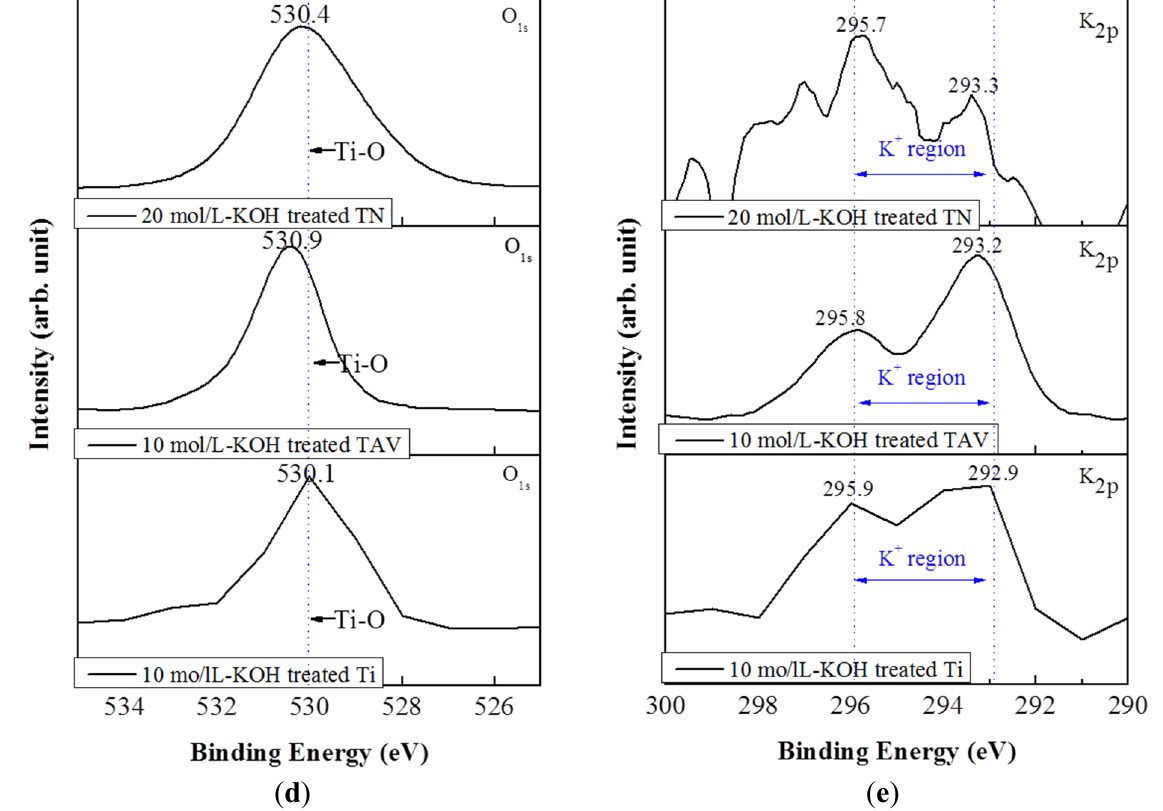
Figure 2. X-ray photoelectron spectroscopy (XPS) spectra of the surface of the Ti, TAV, and TN substrate within the same morphology. ( a ) Wide scan XPS spectra of the surface of the TAV substrate after 10 mol/L-KOH treatment; ( b ) wide scan XPS spectra of the surface of the TN substrate after 20 mol/L-KOH treatment; ( c ) Ti 2 p spectra of the surface of the Ti, TAV and TN substrate; ( d ) O 1 s spectra of the surface of the Ti, TAV and TN substrate; ( e ) K 2 p spectra of the surface of the Ti, TAV and TN substrate. Compared with untreated substrates, K 2 p peaks were clearly observed in all the KOH-treated Ti, TAV and TN substrates. This indicates that K-incorporated end products are formed by Ti–O–K bonding due to the chemical